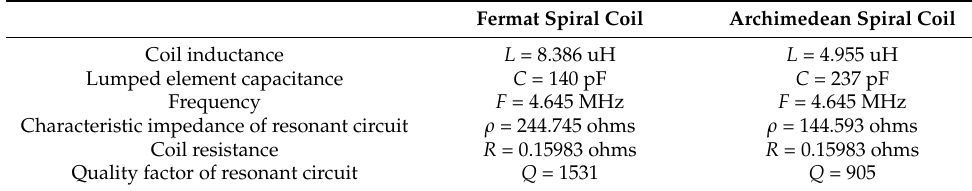
Table 2. Electrical characteristics of elements used in the study of numerical models of Fermat spiral coil and Archimedean spiral